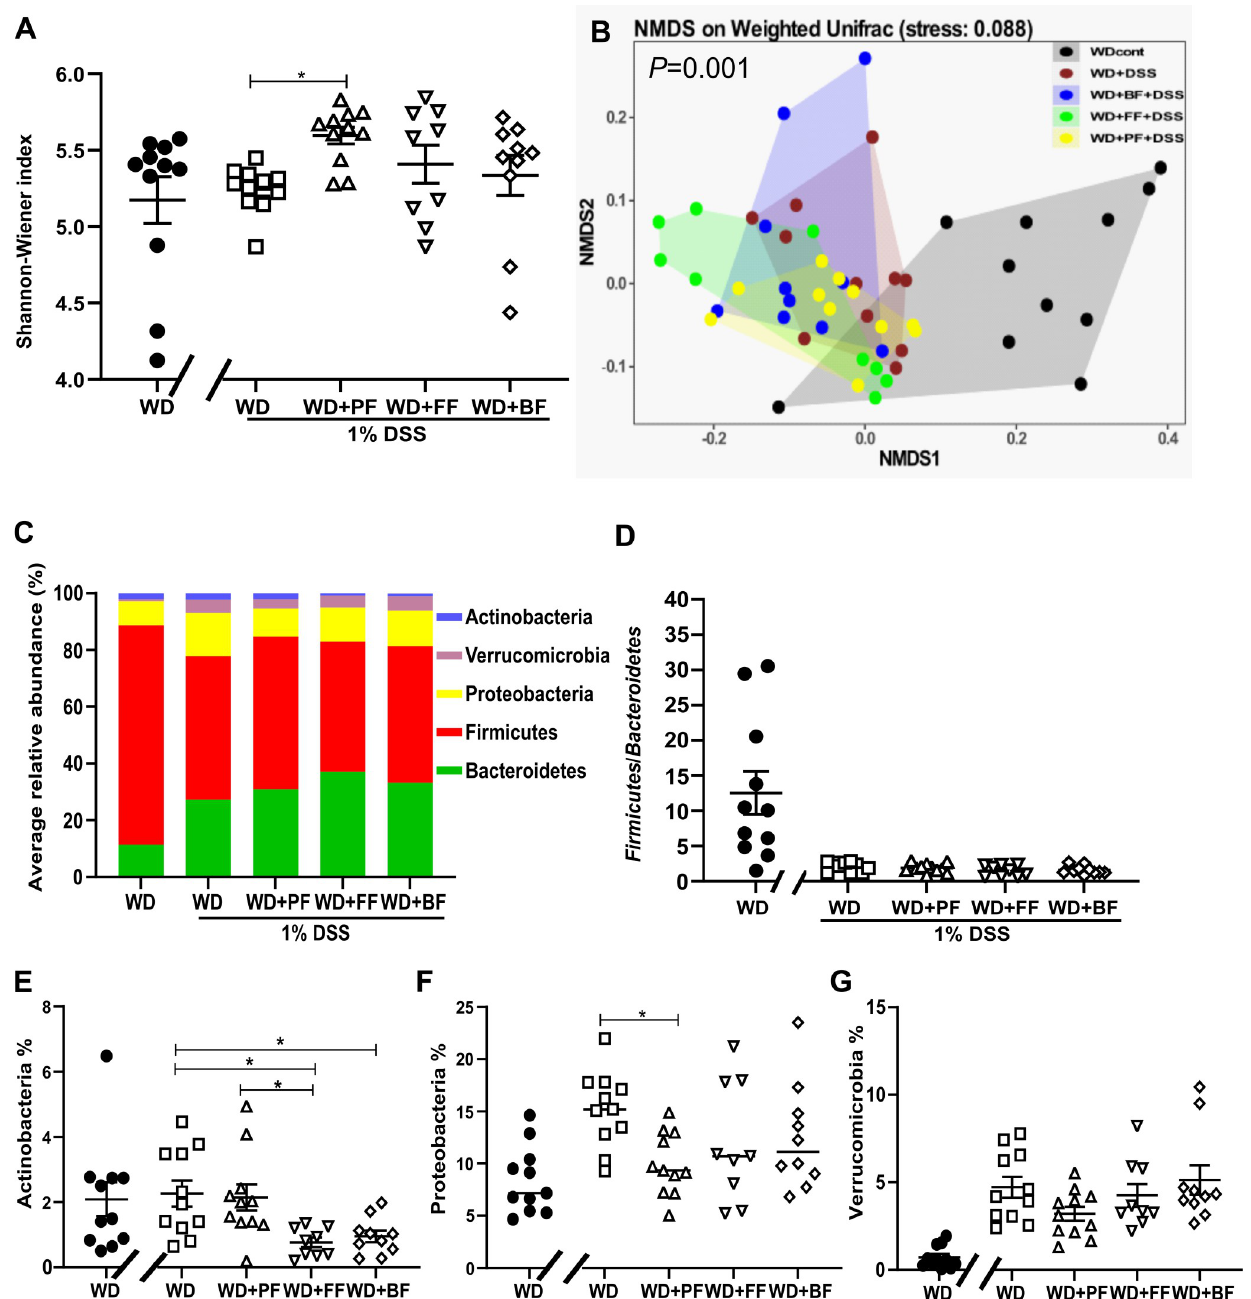
Fig 5. Impact of various faba-bean fractions with WD (WD-PF, WD-FF and WD-BF) on microbiota measures in C57BL/6JRj exposed to 1% DSS. WD without DSS treatment served as negative control. Alpha-diversity (Shannon index) of colonic bacterial communities in feces from WD mice represented as mean with SEM n = 8–11 in each dietary group ( 5A ). Groups were compared using Kruskal-Wallis test since one-way ANOVA could not be performed due to violation of normality assumption. Impact of faba bean fractions on beta-diversity was explored using non-metric multidimensional scaling (NMDS) of weighted UniFrac distances between fecal samples ( 5B ). Colors indicate dietary group. P -value in the plot from global PERMANOVA. Average relative abundance for all detected phyla for each group in fecal samples ( 5C ). Firmicutes/Bacteroidetes ratio in feces ( 5D ), relative abundance of Actinobacteria ( 5E ), Proteobacteria ( 5F ) and Verrucomicrobia ( 5G ) phyla. For panel D Kruskal-Wallis test with Dunn’s multiple comparisons whereas for panel E-G one-way ANOVA with Tukey’s multiple comparison was conducted. � means significantly different ( P < 0.05). Values are expressed as means ± SEM, n = 9–11. Control mice indicated by black circles in the